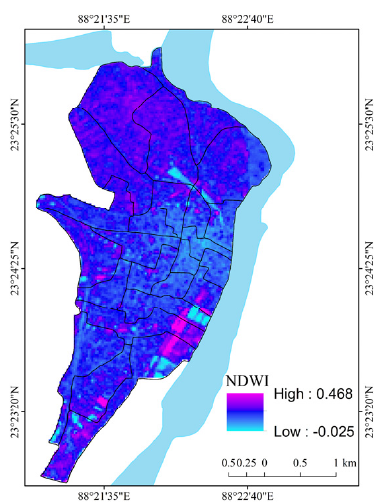
Figure 35. NDVI (2015).